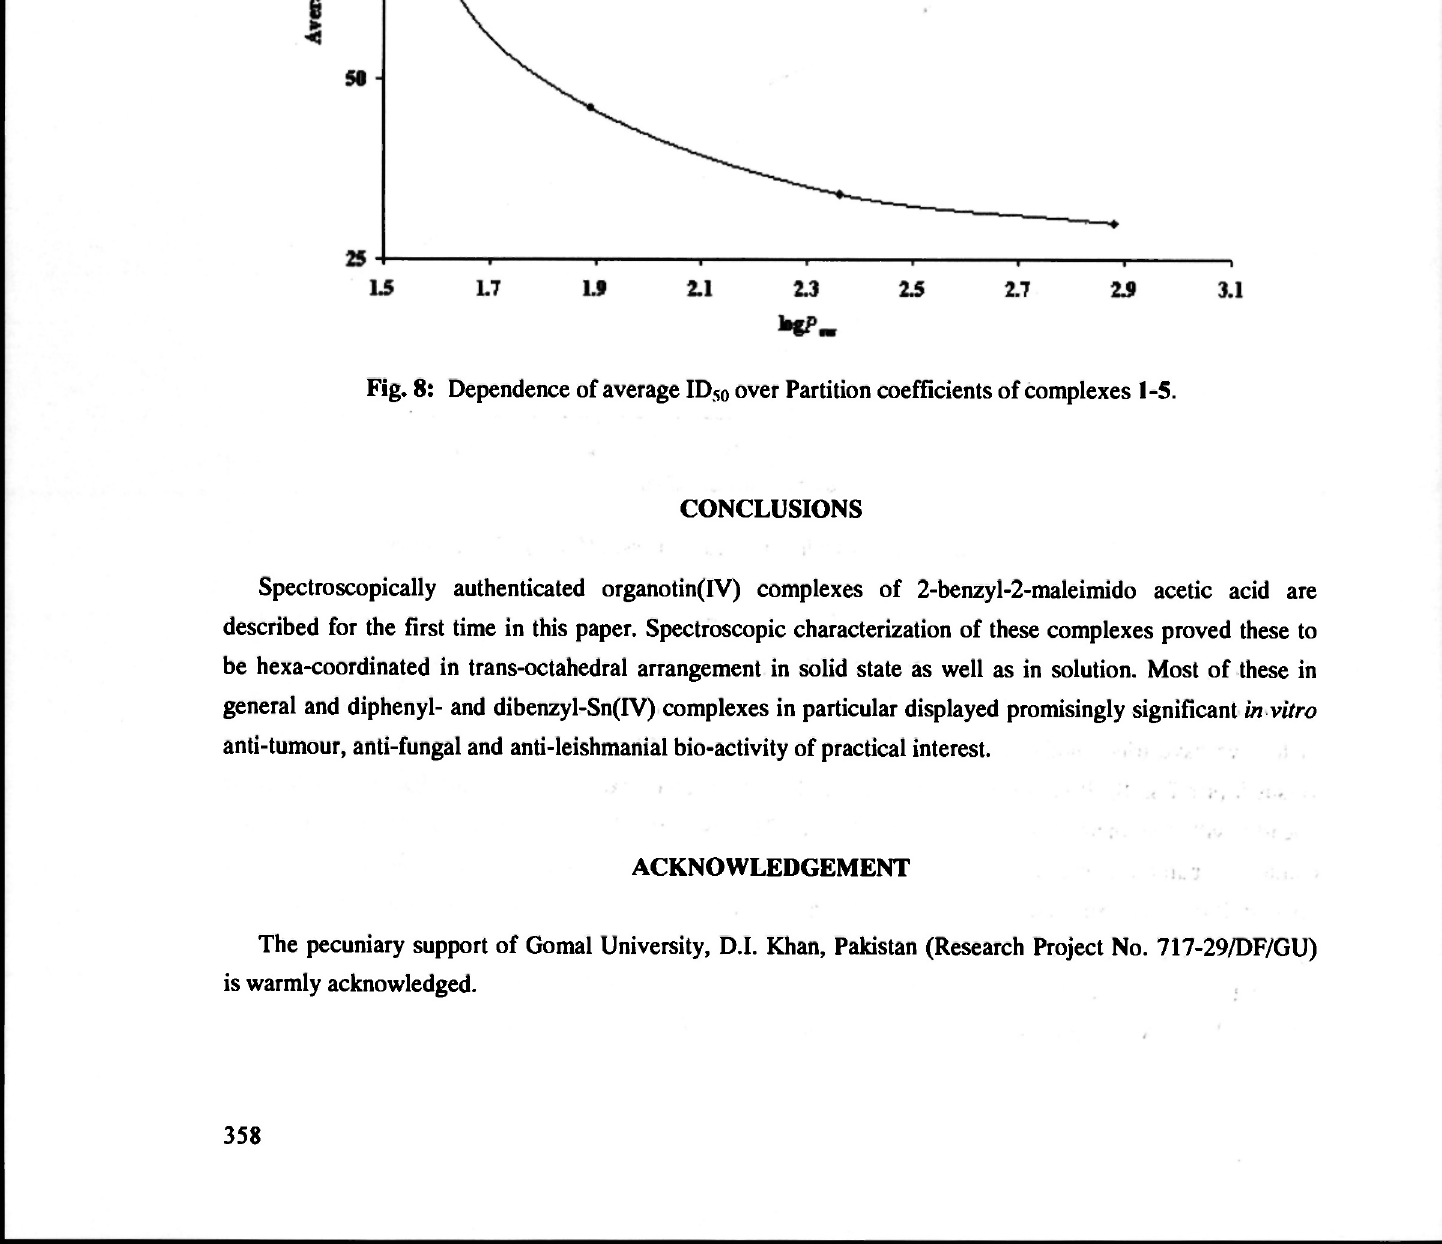
Fig. 8: Dependence of average ID